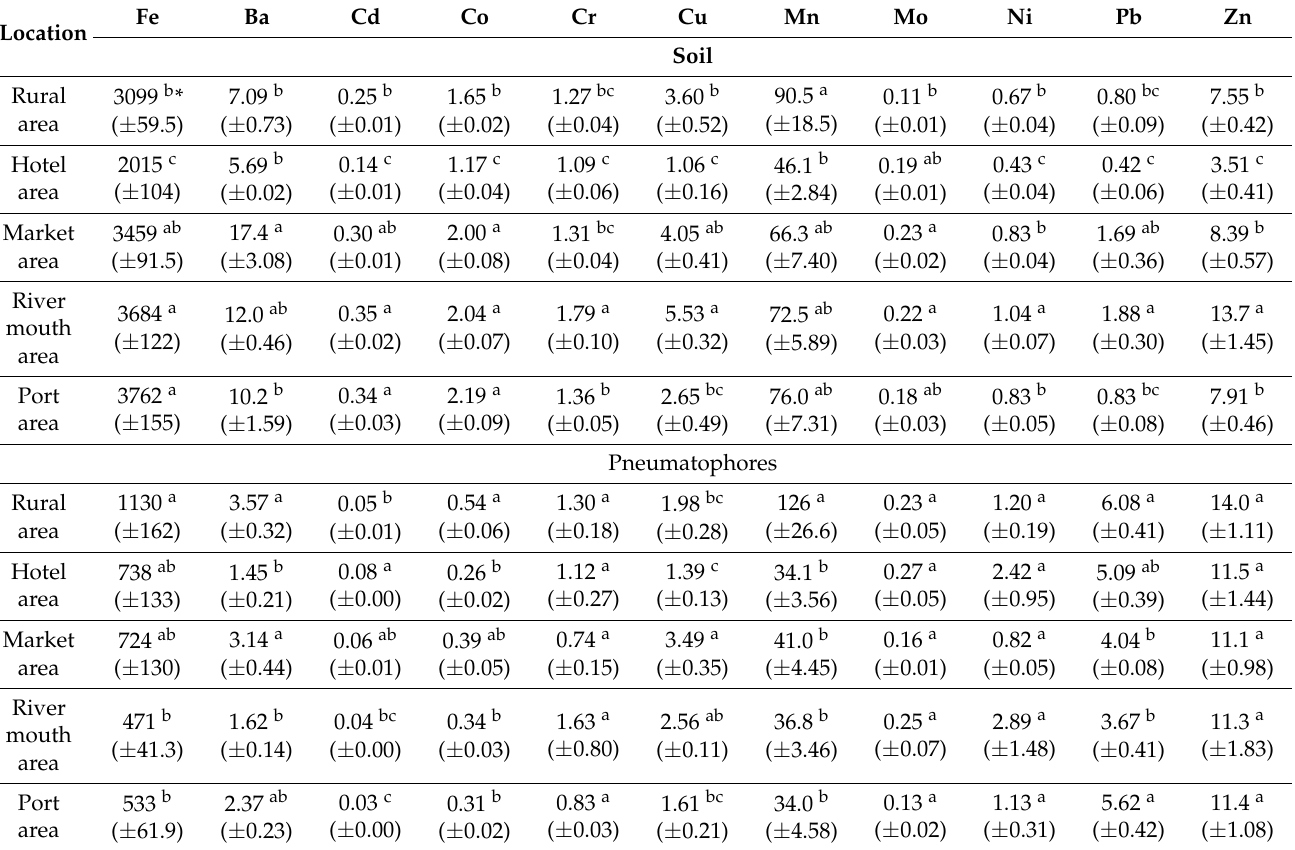
Table 2. Concentrations (mg · kg − 1 ) of TEs found in sediments and pneumatophores of A. alba . Data are mean ± SE, n =